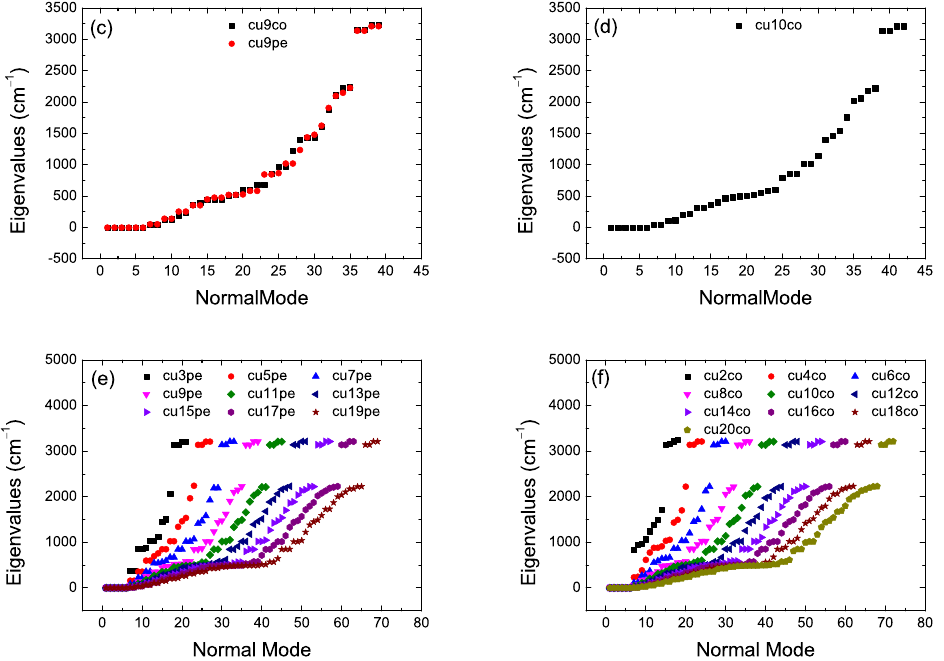
Figure 4. Vibrational analysis of cumulenic molecules. B3LYP/6-31G* level of theory, without any constraint on the position of atoms. ( a ) N = 7, ( b ) N = 8, ( c ) N = 9, ( d ) N = 10, ( e ) N odd (pe), ( f ) N even.